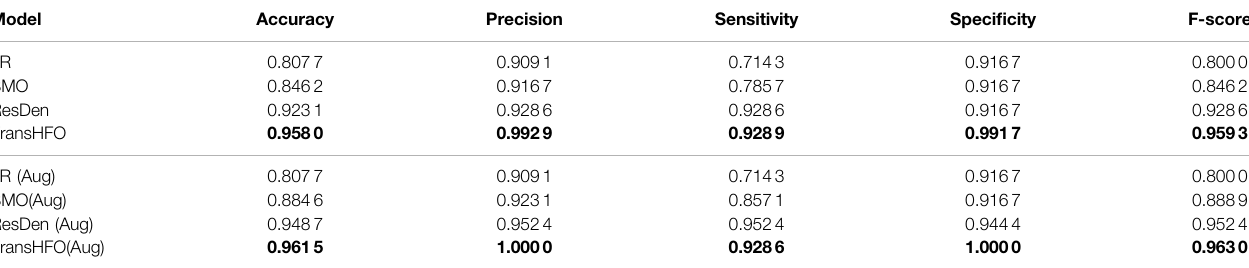
TABLE1| Performancecomparisonofdifferentmodels.TheTransHFOachievedbetterperformancethanLR,SMO,andResDenmodelsinbothnodataaugmentationand data augmentation scenarios.